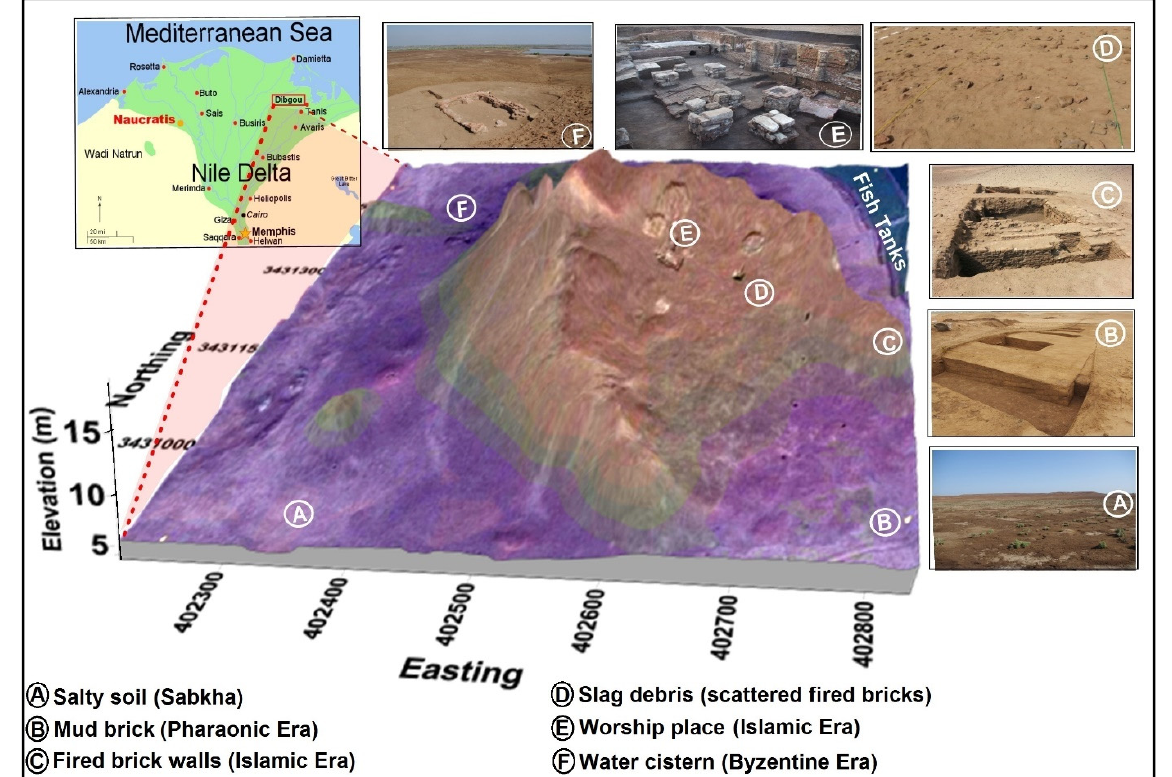
Figure 2. Map of the location, 3D topographic model, and different archaeological ruins of the Tell Dibgou archaeological site [49].